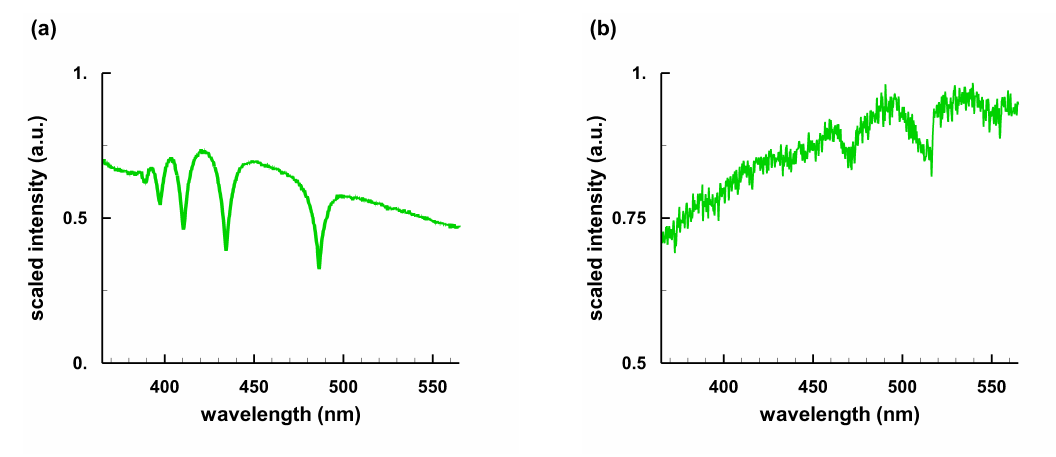
Figure 3. Sirius B and Procyon white dwarf spectra [5]: ( a ) Sirius B at 26 kK; and ( b ) Procyon B at 8